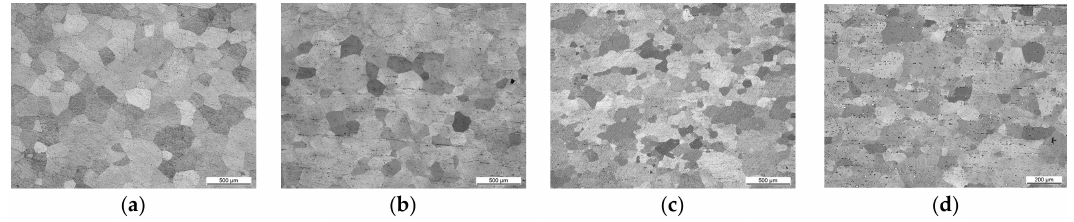
Figure 3. Microstructure of precipitation hardened alloys: ( a ) Mg10Gd; ( b ) Mg10Gd1Nd;